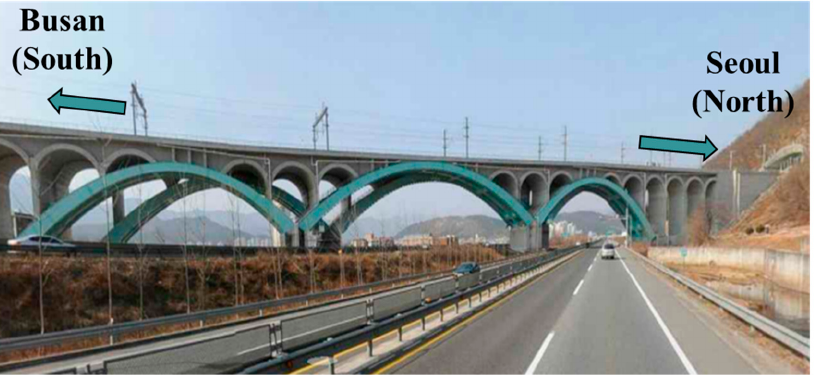
Figure 1. Eonyang Arch Bridge.